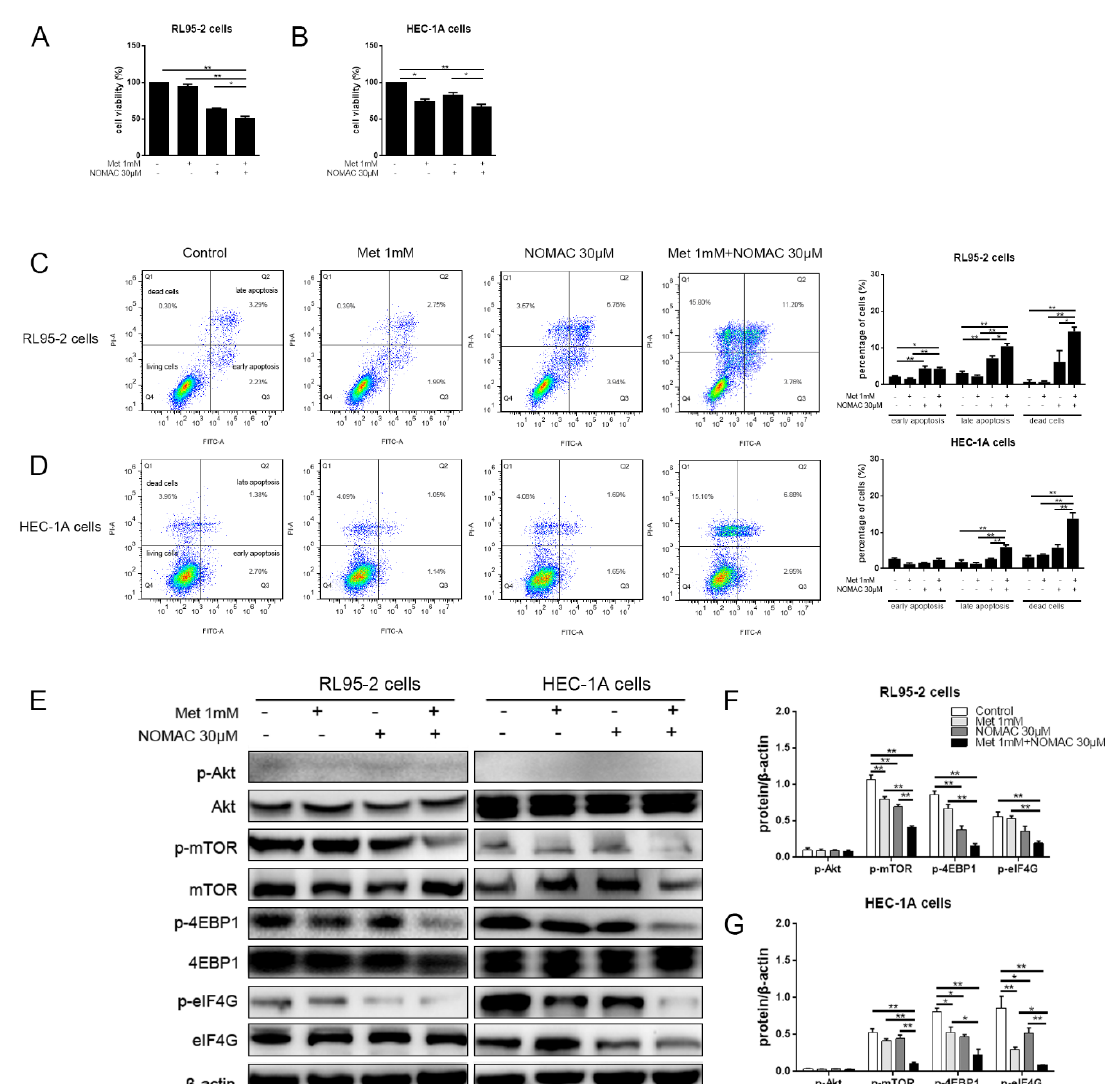
Figure 4. Metformin enhances the suppressive effect of NOMAC and promotes down-regulating of mTOR–4EBP1 / eIF4G in RL95-2 and HEC-1A cells in vitro. Cells were treated with NOMAC, metformin (Met), or the combination for 48 h. ( A and B ) The CCK-8 assay was performed to analyze cell viability. ( C and D ) Cell apoptosis was analyzed using flow cytometry. ( E, F, and G ) The expression level of phospho-Akt (Ser 473), Akt (Pan), phospho-mTOR (Ser 2448), mTOR, phospho-4EBP1 (Ser 65), 4EBP1, phospho-eIF4G (Ser 1108), and eIF4G were assessed by Western blot. These results were typical of three independent experiments. The data were expressed as mean ± SEM. * p < 0.05, ** p < 0.01.